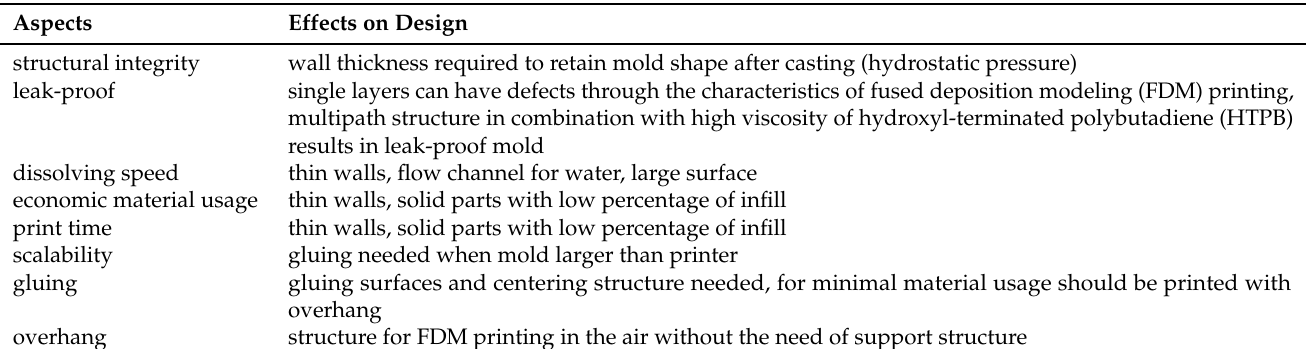
Figure 2. Detailed view of the cross sections of the Monoport ( left ) and the Star ( right ). Rotated Star and Star share the same cross section. Table 1. Overview over the design aspects and their